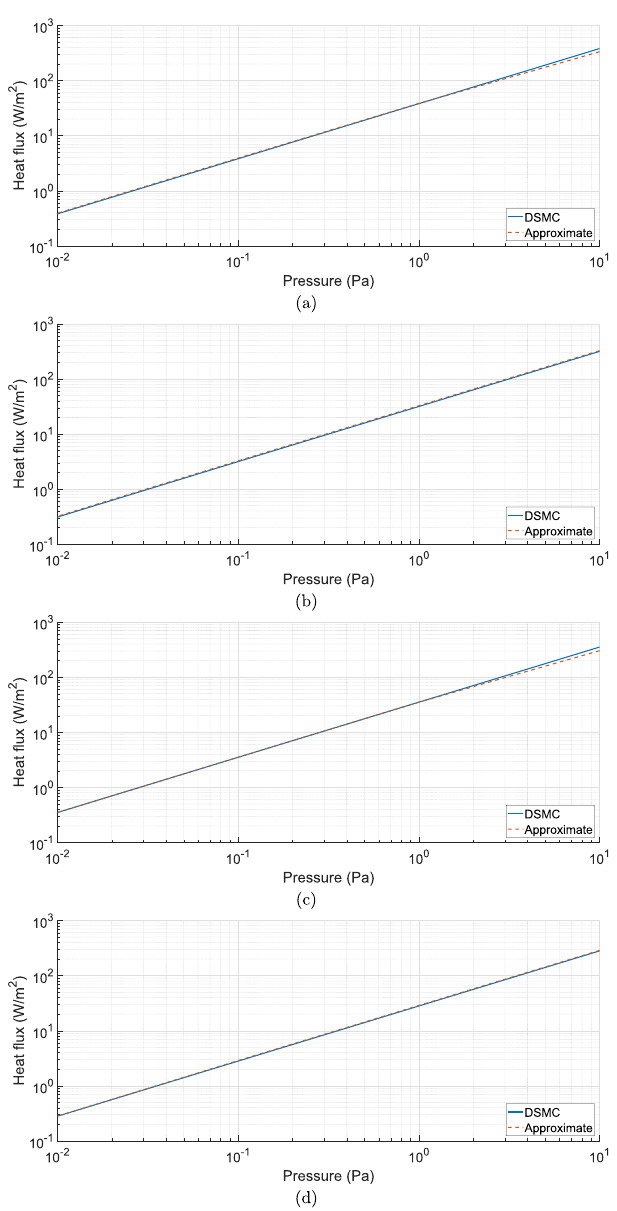
Figure 3. Comparison between the heat flux computed by the DSMC method (solid lines) and the one computed from the diffusive-approximate one (dashed lines) evaluated at the top ( a ) and bottom ( b ) surface of the hotter bolometer and at the top ( c ) and bottom ( d ) surface of the colder bolometer for different values of the pressure p